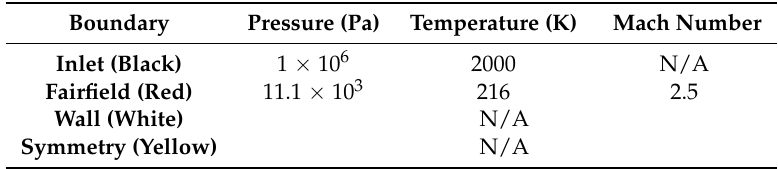
Table 2. Boundary